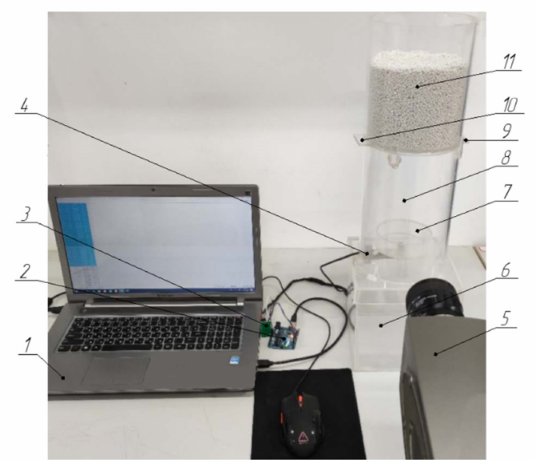
Figure 4. Granular fertilizer discharge time ( DT ) measurement of the sandglass test: (1) Laptop; (2) Arduino Uno board; (3) HX711 load cell amplifier; (4) micro load cell; (5) high-speed video camera; (6) bottom vessel; (7) inner vessel; (8) cylinder; (9) right plug; (10) left plug; (11) upper